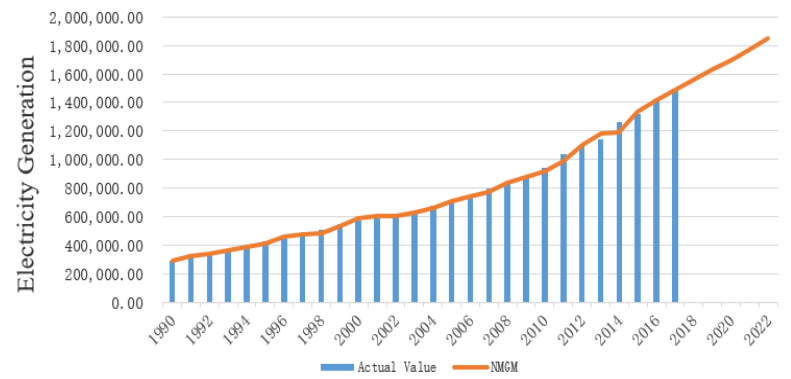
Figure 16. The fitting degree between the NMGM model in GWh and the actual generation capacity, 1990–2022.